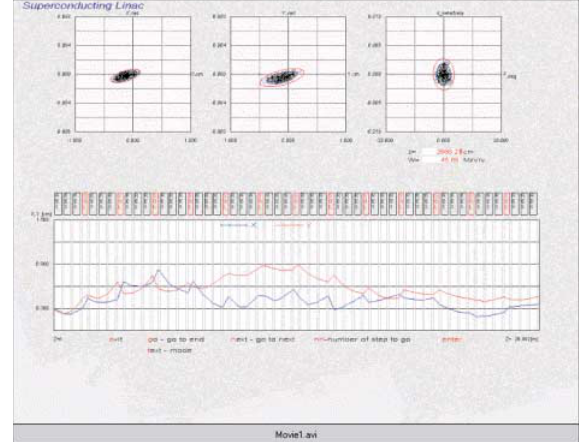
FIG. 4. (Video) Proton beam motion in the driver linac section containing 115 MHz QWRs.